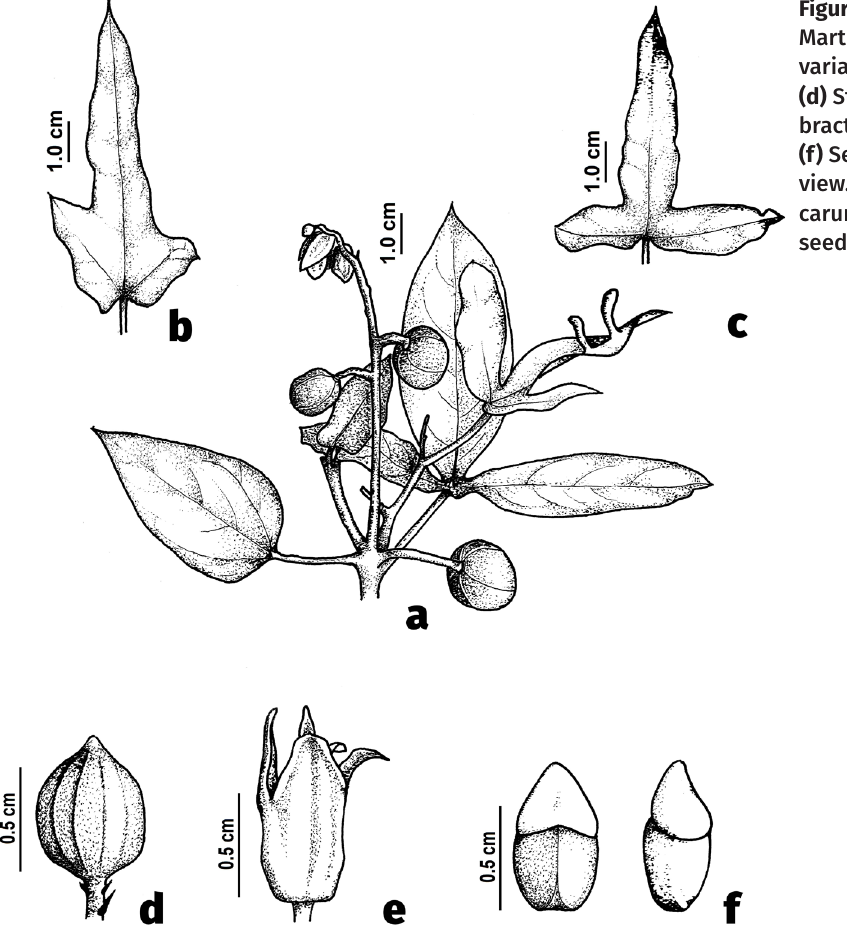
Figure 1. Manihot irregularis M. Martins & Ledo. (a) with leaves variably lobed. (b) and (c) Leaves. (d) Staminate bud with bracts and bracteoles. (e) Staminate flower. (f) Seeds in frontal and lateral view. Observe the proportion of caruncle in relation of the size of